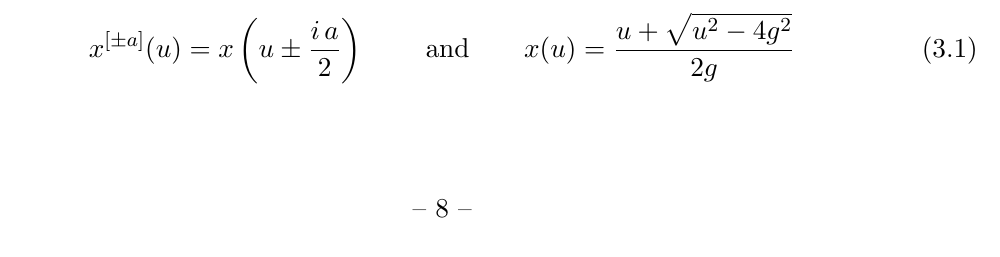
Figure 4 . On the left the tensorial contraction of two hexagon form factors of three mirror particles with bound state numbers a i . The dashed lines denote the sum over psu (2 indexes on each representation a i . The twists t L;R account for the chemical potentials which act on each copy psu (2 2) L and psu (2 2) R . Using the invariance of psu (2 j j the twists and unitarity (2.9) we simplify this contraction. The result is a product of three twisted transfer matrices (with twist t = t L t R ) on representations a i